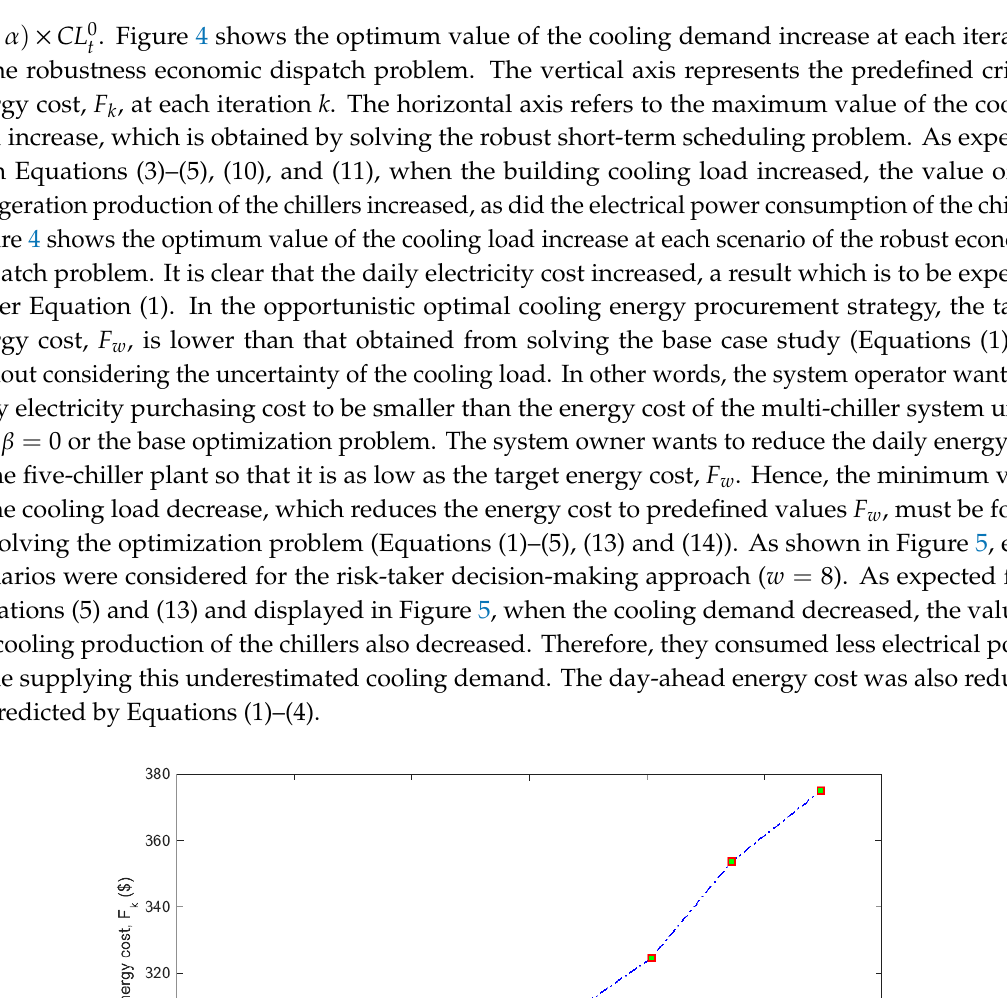
Figure 5. The minimum value of the cooling load decrease at each iteration of the opportunistic optimal chiller loading (OCL) strategy.